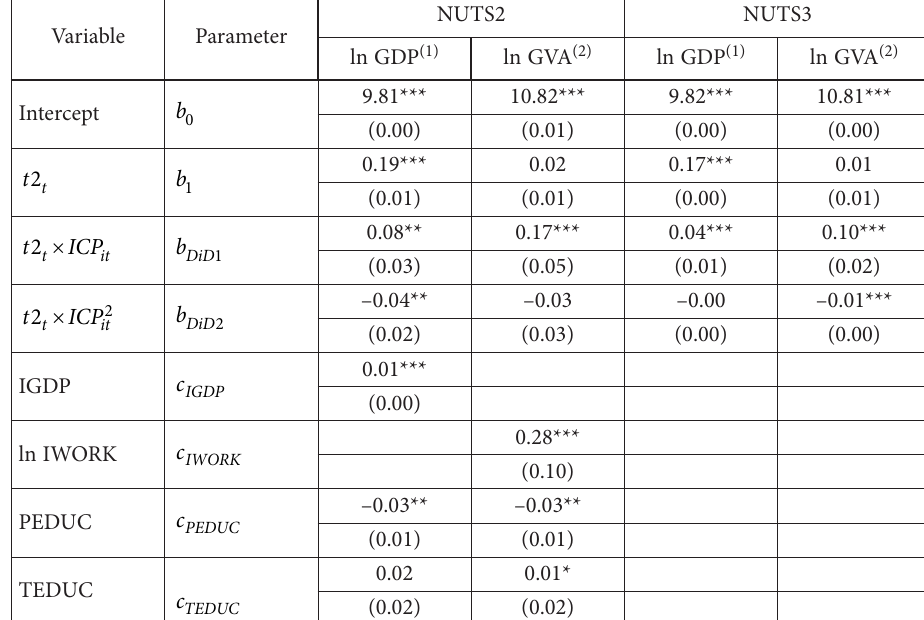
Table 2. Fixed effects estimates of 2000–2006 programming